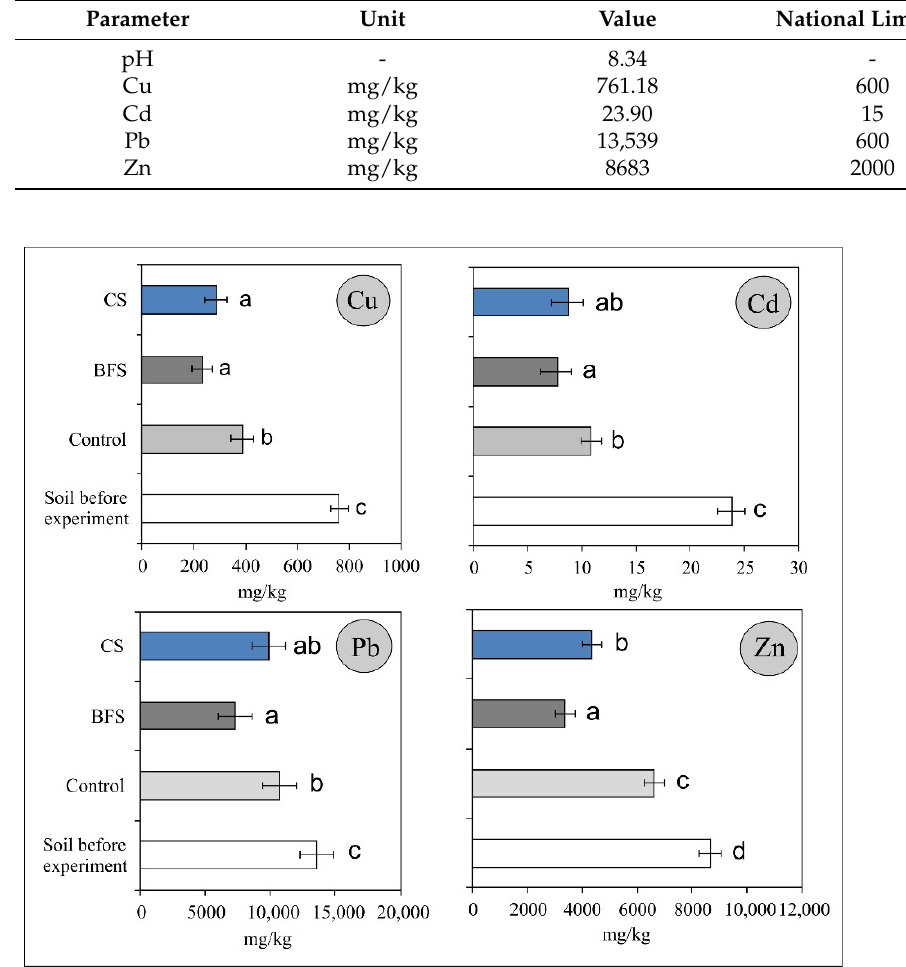
Figure 5. Contents of Cu, Cd, Pb, and Zn in the soil after the application of BFS and CS.